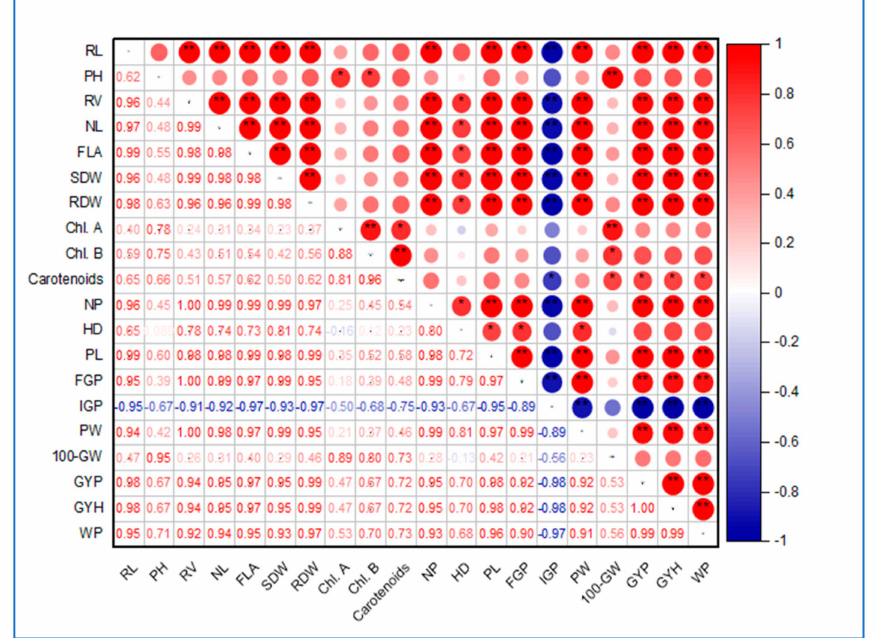
Figure 4. Heat map correlation plot describing Pearson’s correlation between the studied traits of rice cultivars under drought irrigation conditions. RL: root length (cm); PH: plant height (cm); RV: root volume (mm 3 ); NL: number of leaves; FLA: flag leaf area (cm 2 ); SDW: shoot dry weight (g); RDW: root dry weight (g); Chl. A: chlorophyll A (mg g − 1 FW); Chl. B: chlorophyll B (mg g − 1 FW); NP: number of panicle; HD: heading date (day); PL: panicle length (cm); FGP: fertile grain panicle − 1 ; IGP: infertile grain panicle − 1 ; PW: panicle weight (g); 100-GW: 100-grain weight (g); GYP: grain yield plant − 1 (g); GYH: grain yield per hectare (t); and WP: water productivity (kg m 3 ). The large and medium red (positive) and blue (negative) circles indicates a significant (* p ≤ 0.05) or highly significant correlation (** p ≤ 0.01), while the small red (positive) and blue (negative) circles indicates non-significant